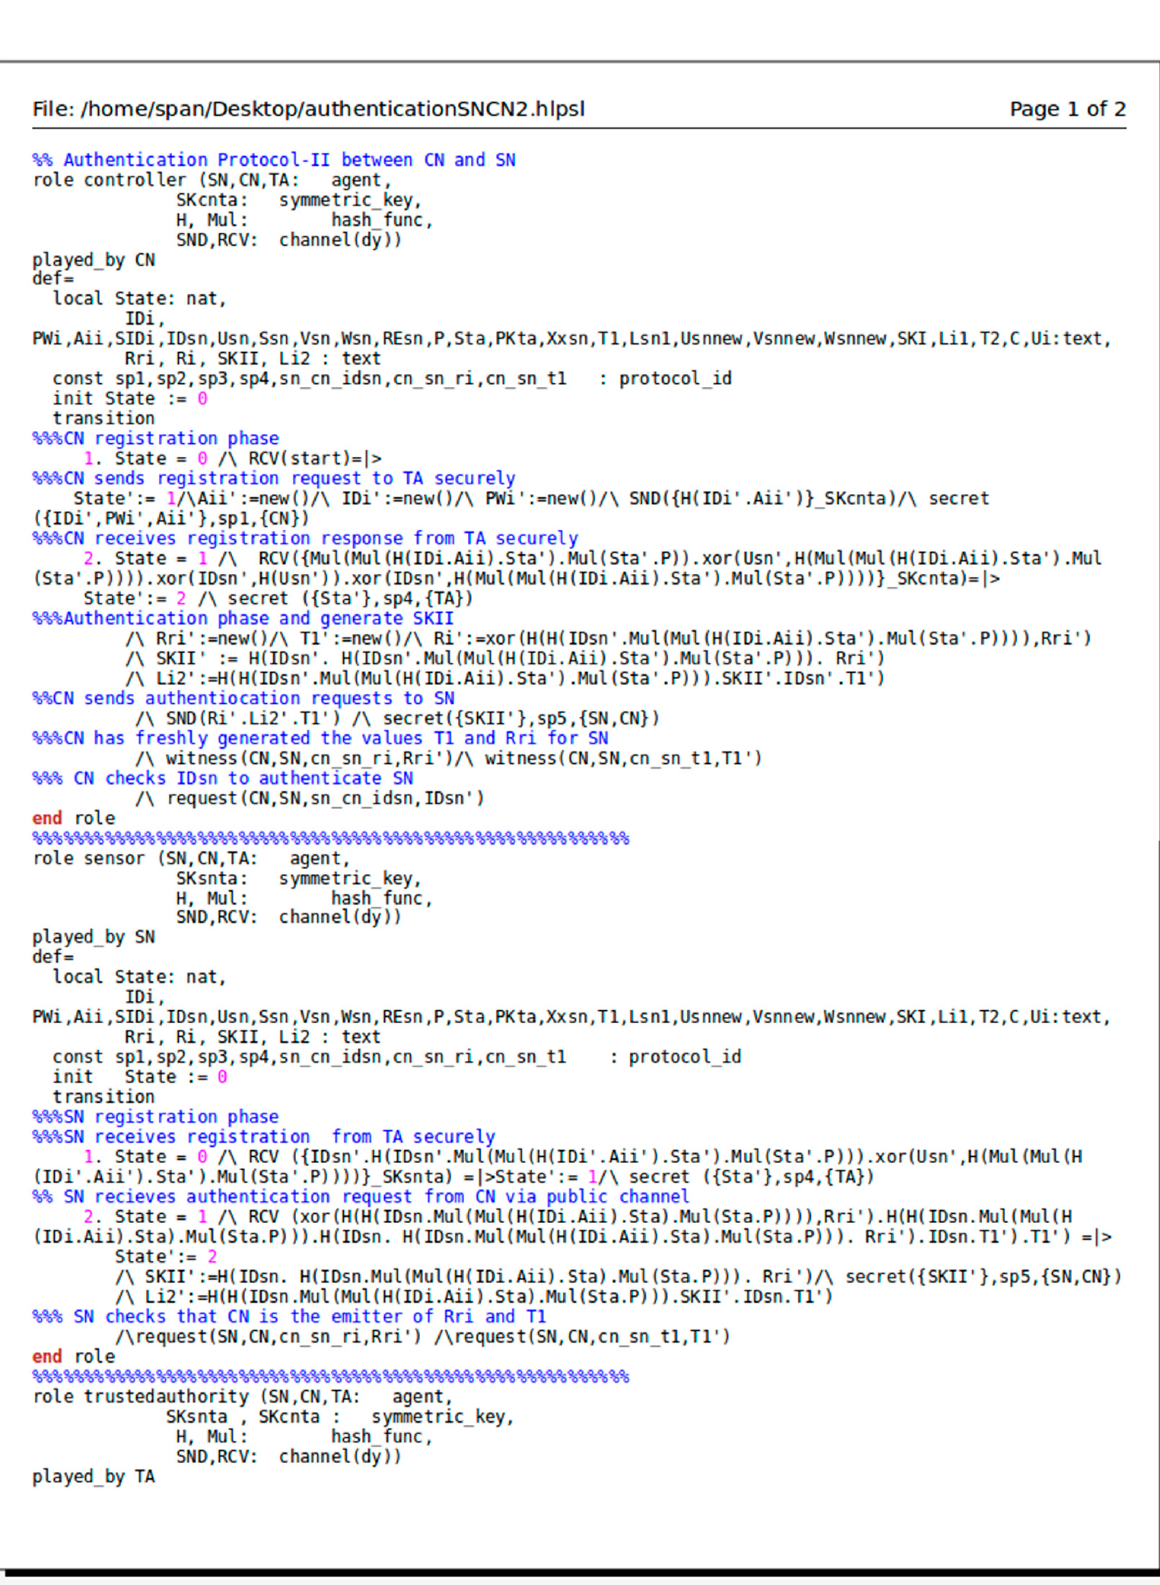
Figure 8. HLPSL code for protocol-II.